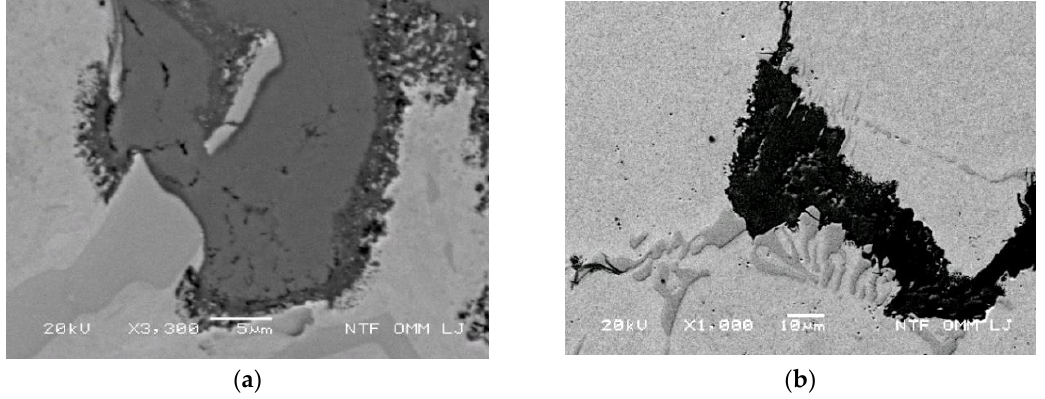
Figure 15. Oxidized area of matrix adjacent to carbides at test temperature of 700 °C: ( a ) approximately 5 wt. % of Mo in carbides and ( b ) approximately 2.2 wt. % of Mo in carbides.